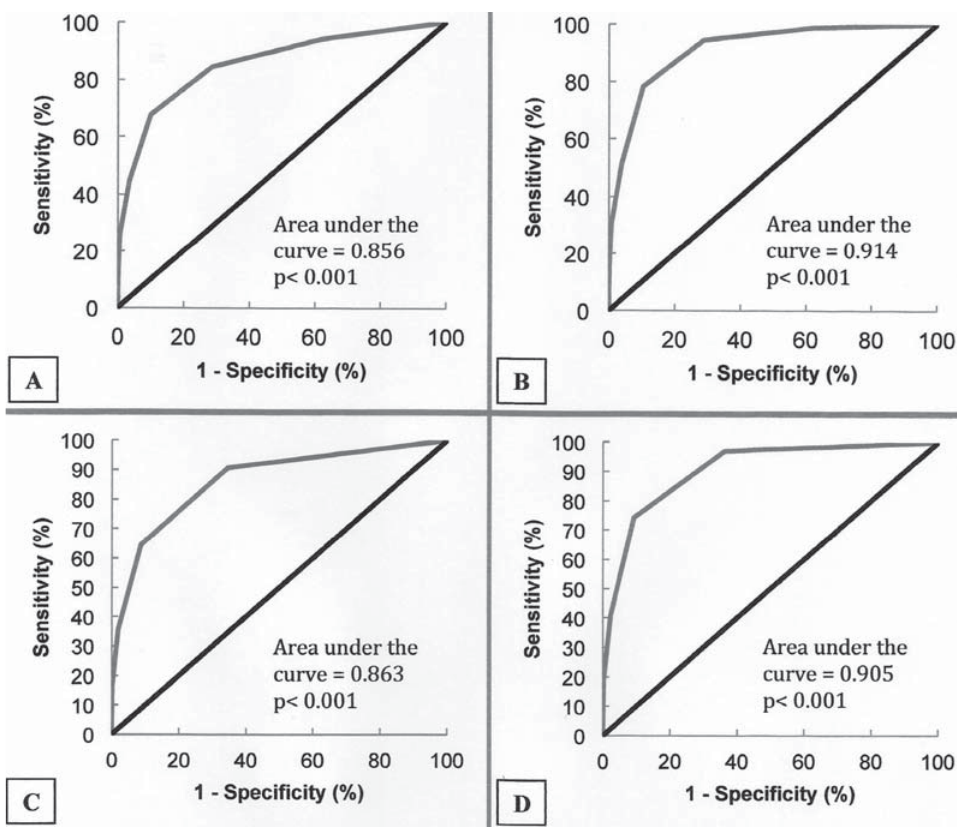
Figure 1- Receiver operating characteristic (ROC) curves for the diagnosis of overall temporomandibular disorders (TMD) and painful TMD with the eight-item and the four-item questionnaires, compared with the reference standard [Research Diagnostic Criteria for Temporomandibular Disorders (RDC/TMD) Axis I]. (A) ROC curve for diagnosing overall TMD with the eight-item questionnaire; (B) ROC curve for diagnosing painful TMD with the eight-item questionnaire; (C) ROC curve for diagnosing overall TMD with the four-item questionnaire; and (D) ROC curve for diagnosing painful TMD with the four- item